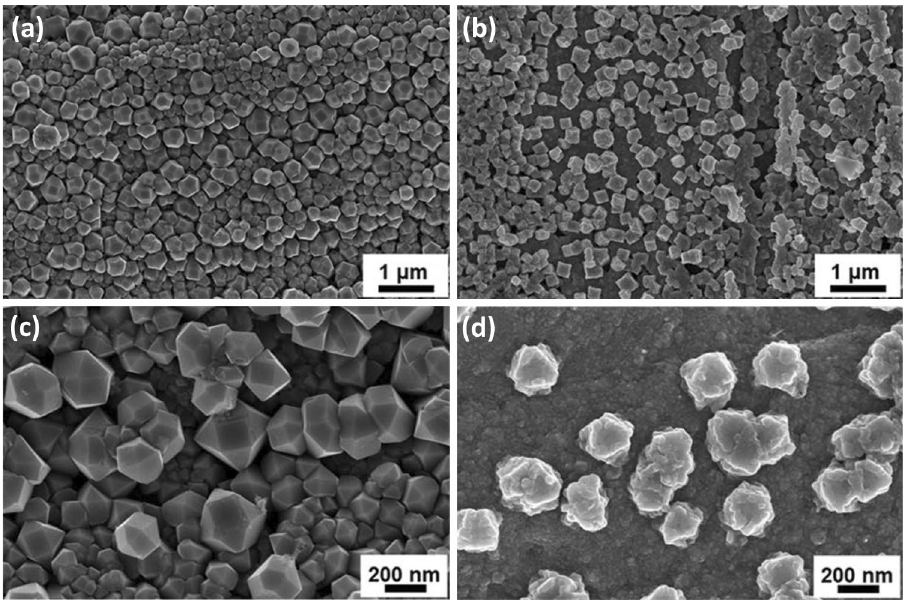
Figure 1. FESEM images of the fabricated photocathodes ( a,c ) before and ( b , d ) after annealing at 350 °C in the air for 1 h.